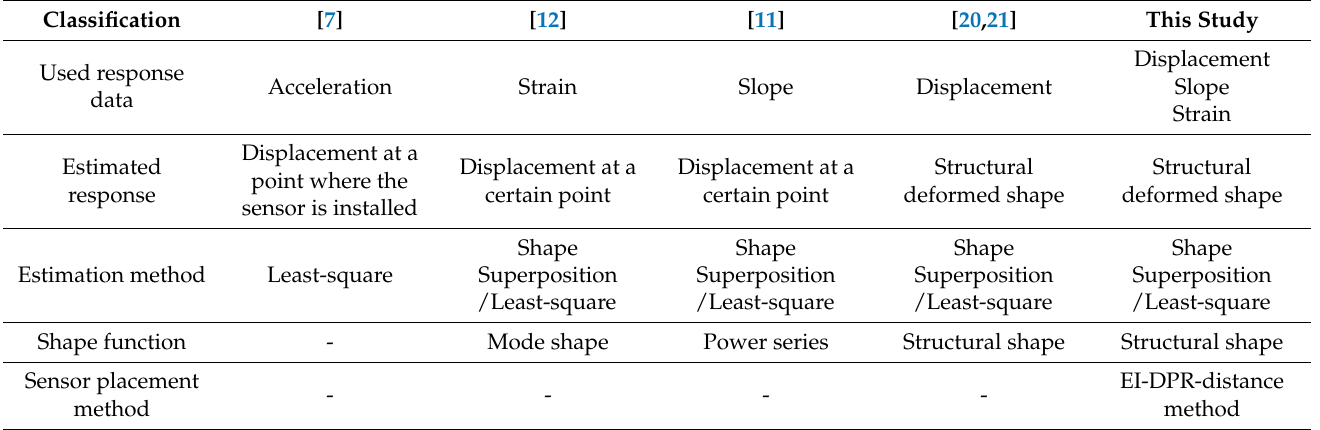
Table 1. Comparison of methodologies between this study and previous